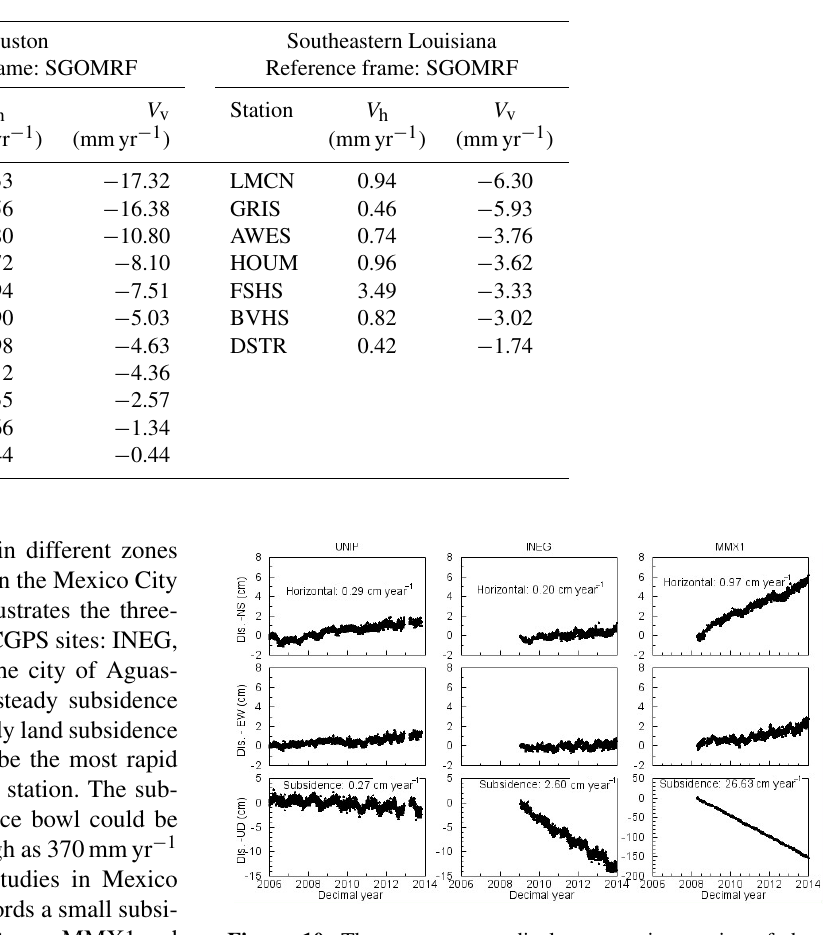
Figure 10. Three-component displacement time series of three CGPS stations in central Mexico. The reference frame is SGOMRF. The locations of UNIP and MMX1 are marked in Fig. 7 and the lo- cation of INEG is marked in Fig.